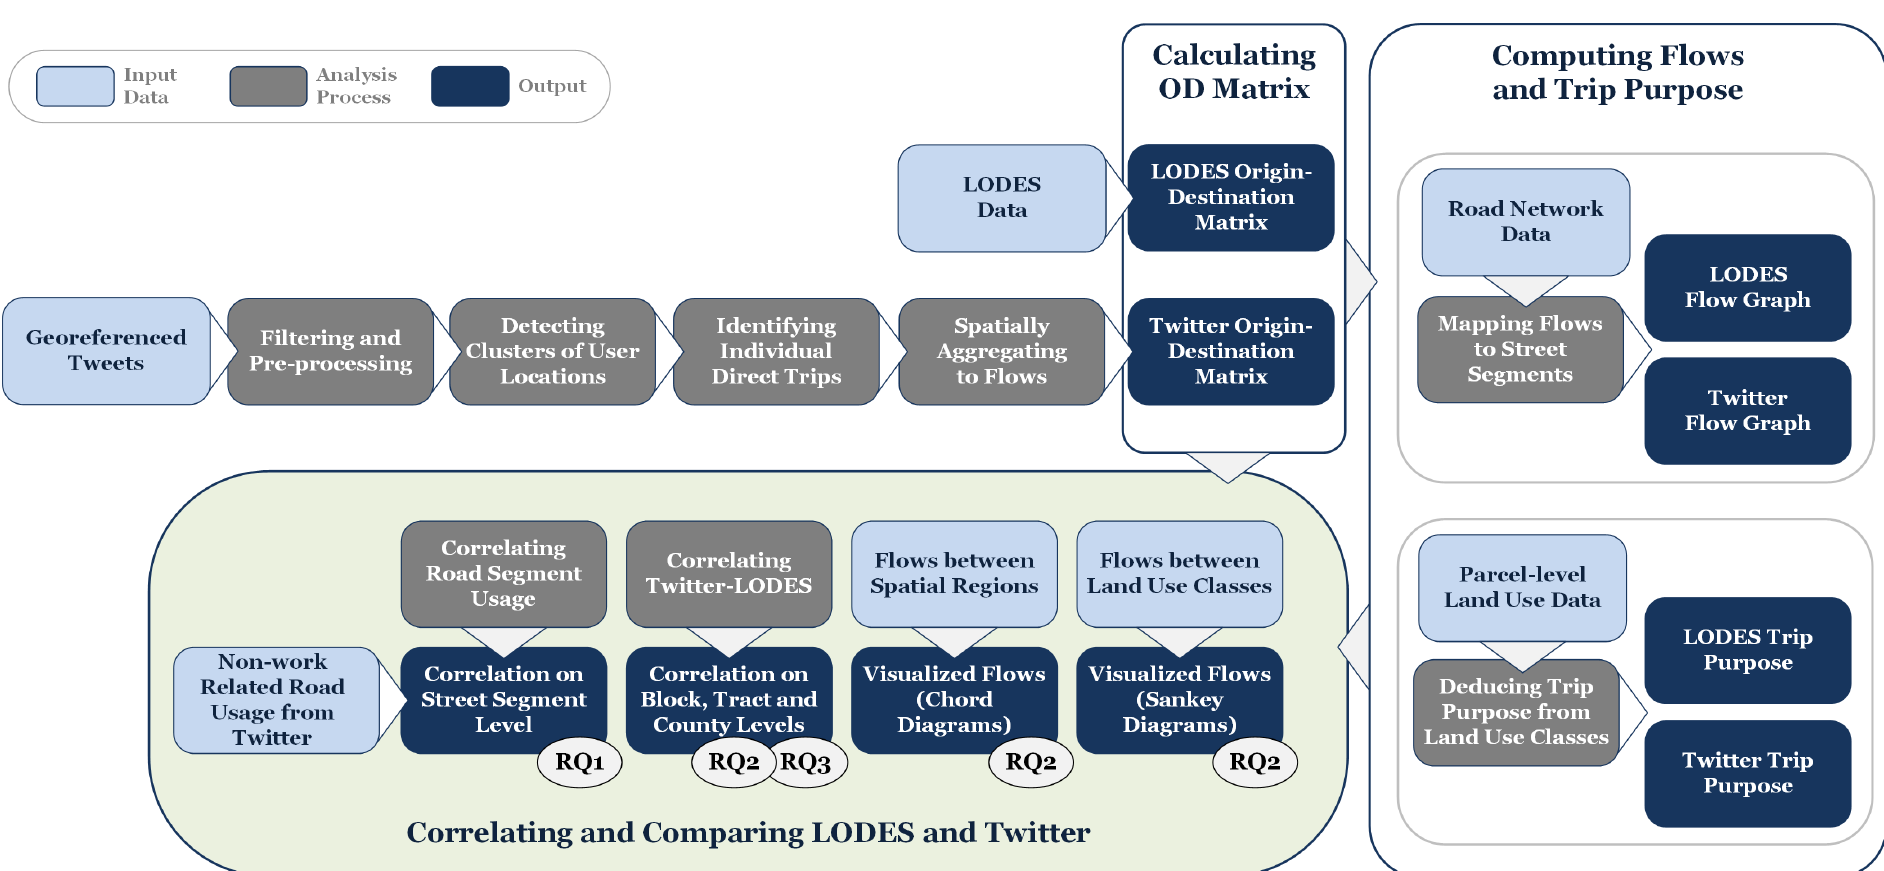
Figure 3. Schematic workflow illustrating input data, analysis steps and